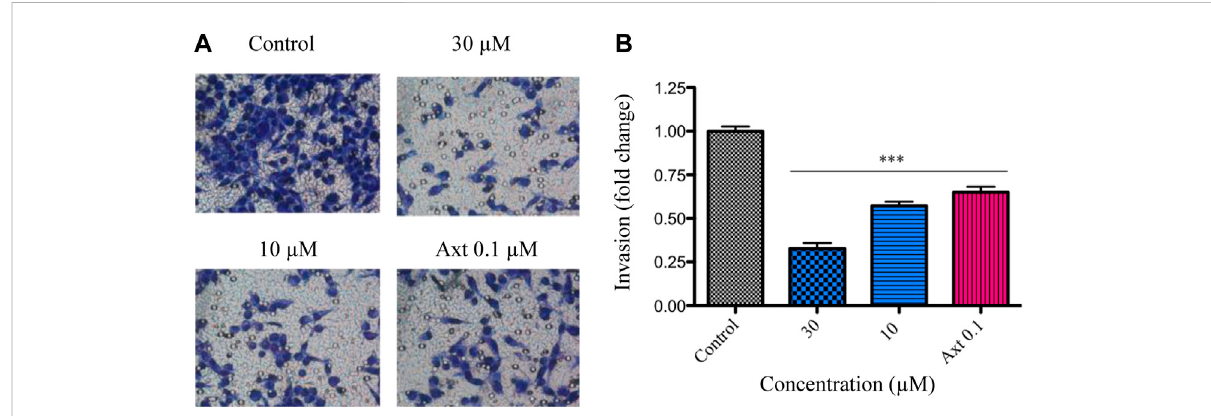
FIGURE 5 MDA-MB-231cellsweretreatedwithcompound 3 (30or10 µM)oraxitinib(Axt,0.1 μ M),andtheMatrigelinvasionassaywasperformedina16 h